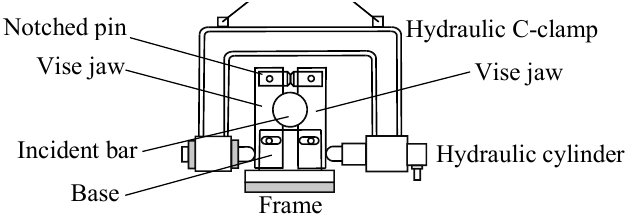
Figure 2 : TSHB clamping mechanism by Pao & Gilat [8].